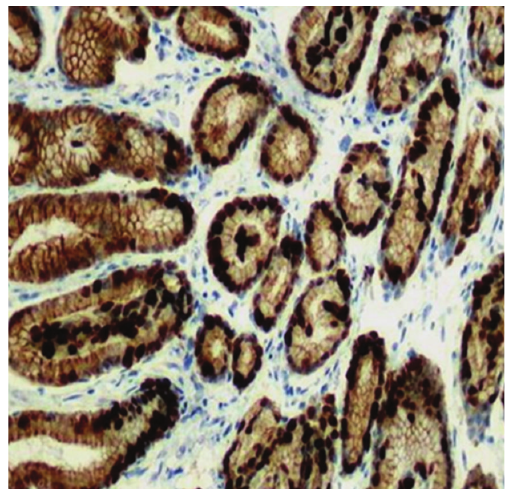
Figure 3: Ki-67 expression in the gastric mucosa (magnification × 100). The immunoreactive cells (dark nuclei) are mainly located at the base of the